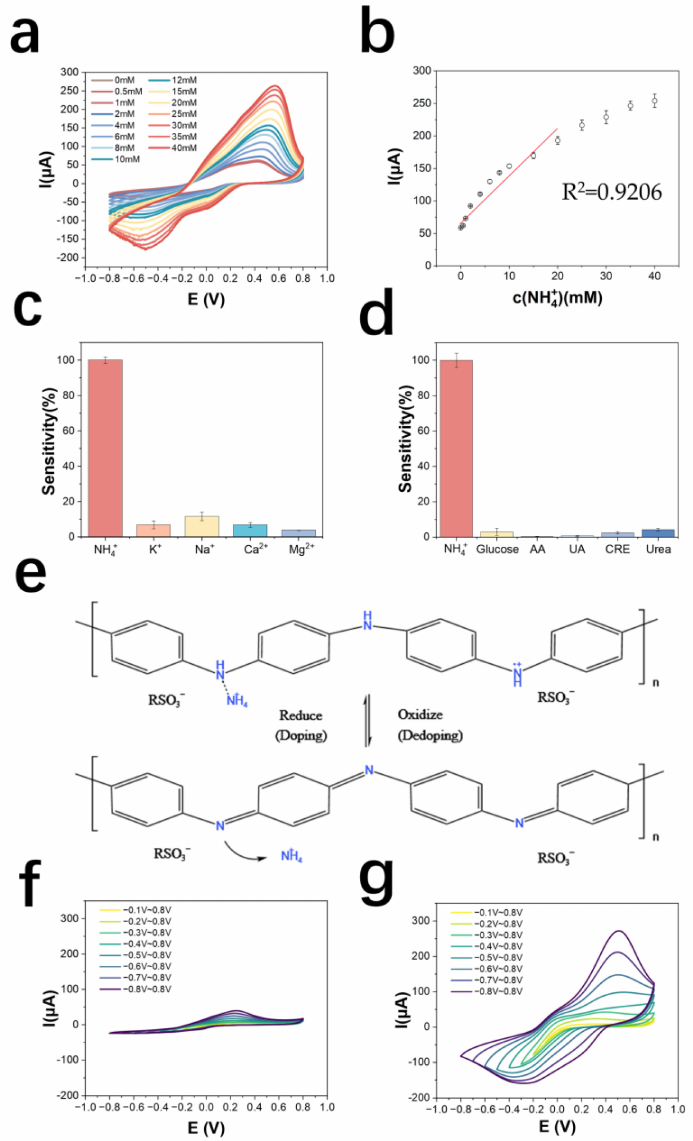
Figure 3. ( a ) Cyclic voltammetric curves of PANI: PSS in solutions with different concentrations of ammonium chloride; ( b ) NH 4+ detection calibration curve; ( c ) selectivity of PANI: PSS electrode for cations (the added cations were all at a concentration of 5 mM); ( d ) selectivity of PANI: PSS electrode for metabolites (n = 3) (The electrode was immersed in 0.01 M PBS solution and cyclic voltammetric scanning was performed. 5 mM NH 4 Cl and common metabolite solutions including 50 µ M glucose (Glucose), 100 µ M ascorbic acid (AA), 150 µ M uric acid (UA), 1 mM creatinine (CRE), and 10 mM urea (Urea) were sequentially added; cyclic voltammetric scans were performed again after each addition of interfering metabolite solutions. The absolute value of the change in the oxidation peak current of the cyclic voltammetric curve is the interference brought by the interfering metabolite); ( e ) Dynamic doping/dedoping process of PANI: PSS by NH 4 + ; ( f ) 0.01 M PBS in dynamic reduction potential cyclic voltammetric curve; ( g ) dynamic reduction potential cyclic voltammetric curve in 5 mM ammonium chloride